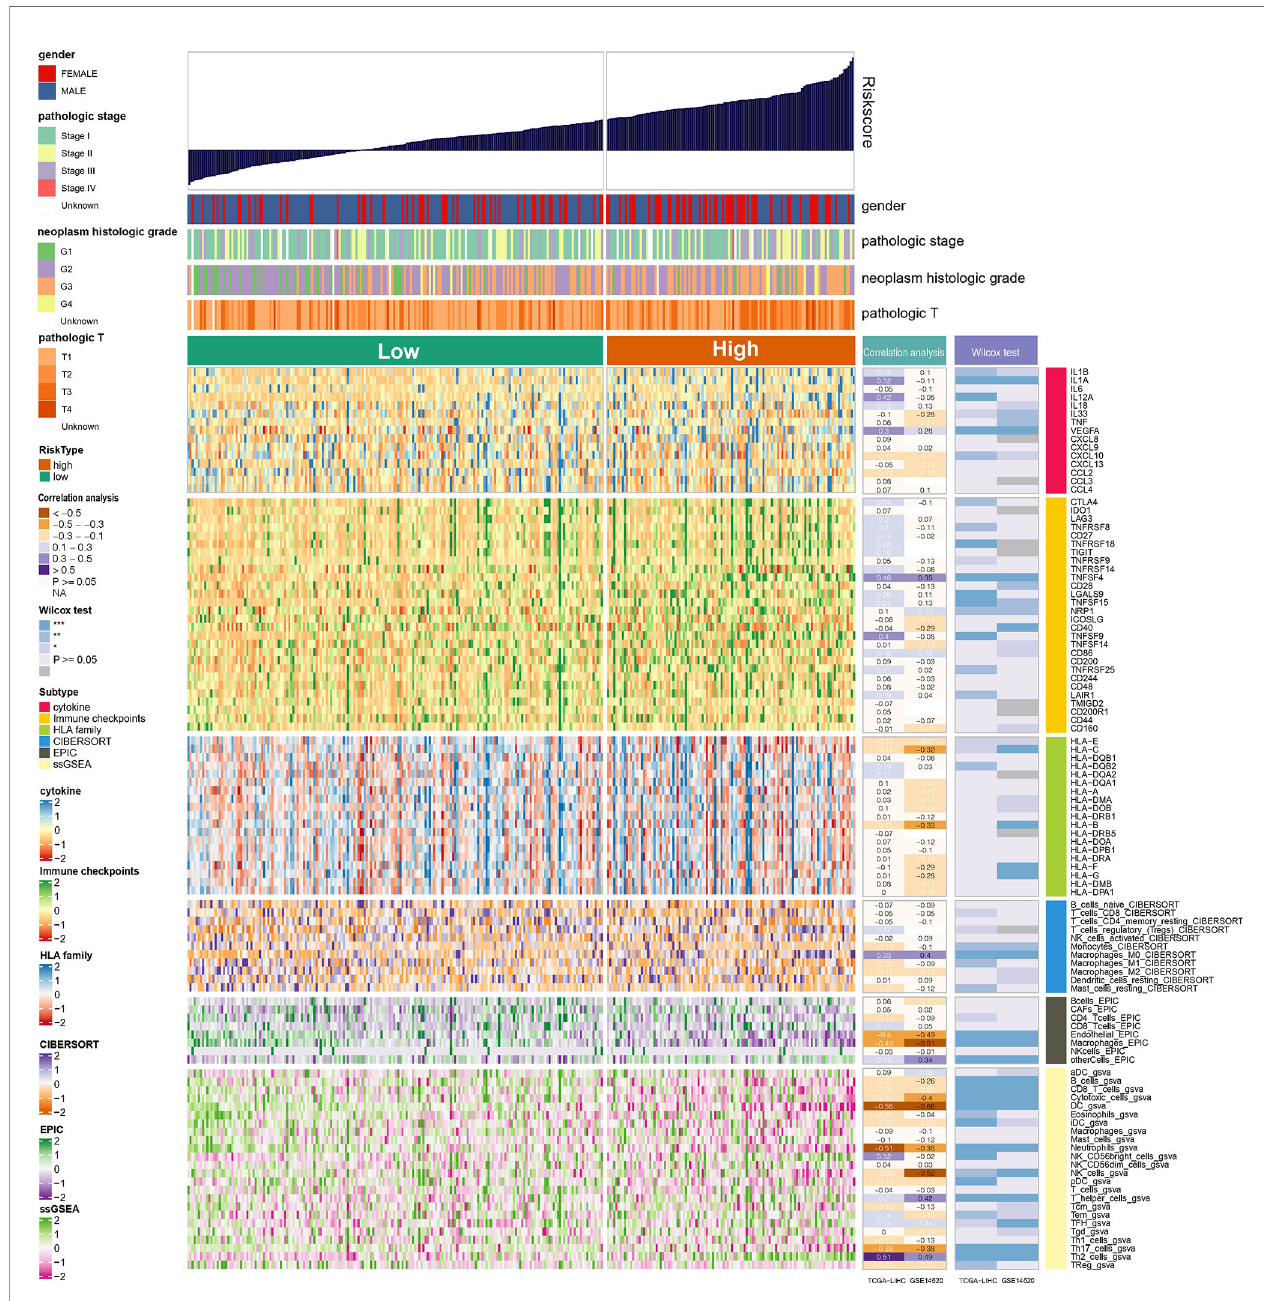
FIGURE 5 | Landscape of cytokine, immune checkpoints, HLA family genes, and immune cell in fi ltrations in the low- and high-NRS groups. Correlation analysis for NRS and expression and immune in fi ltration. Wilcox tests were used to detect the difference in genes expression and immune in fi ltration between low- and high-NRS groups. *p<0.05, **p<0.01,